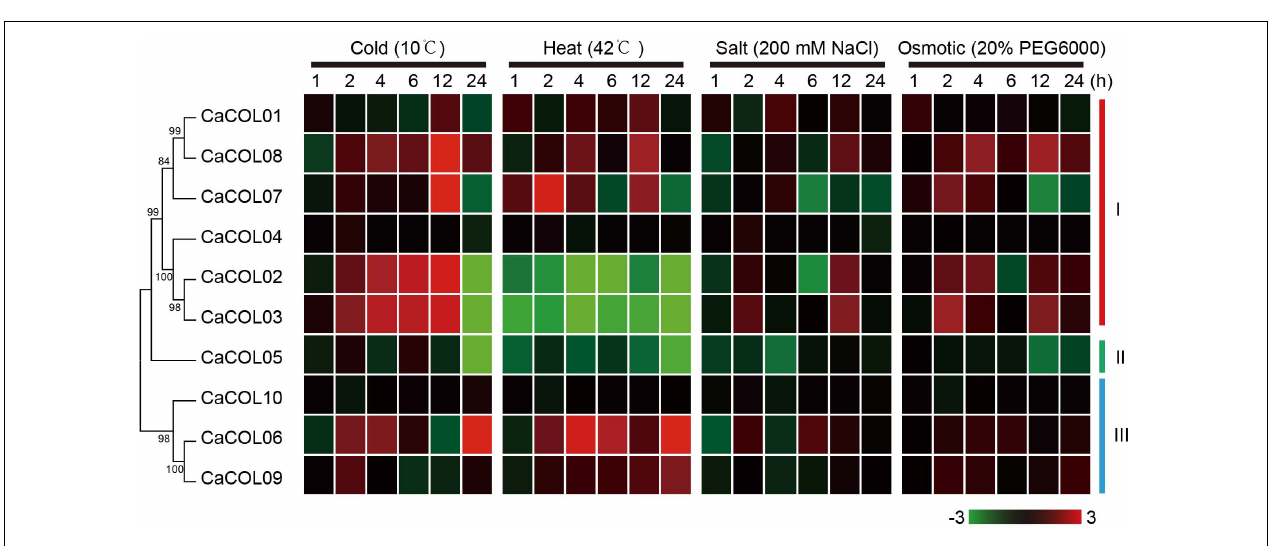
FIGURE 9 | Expression of CaCOL genes under cold, heat, salt, and osmotic stress. The bar at the bottom of each heat map represents the relative expression